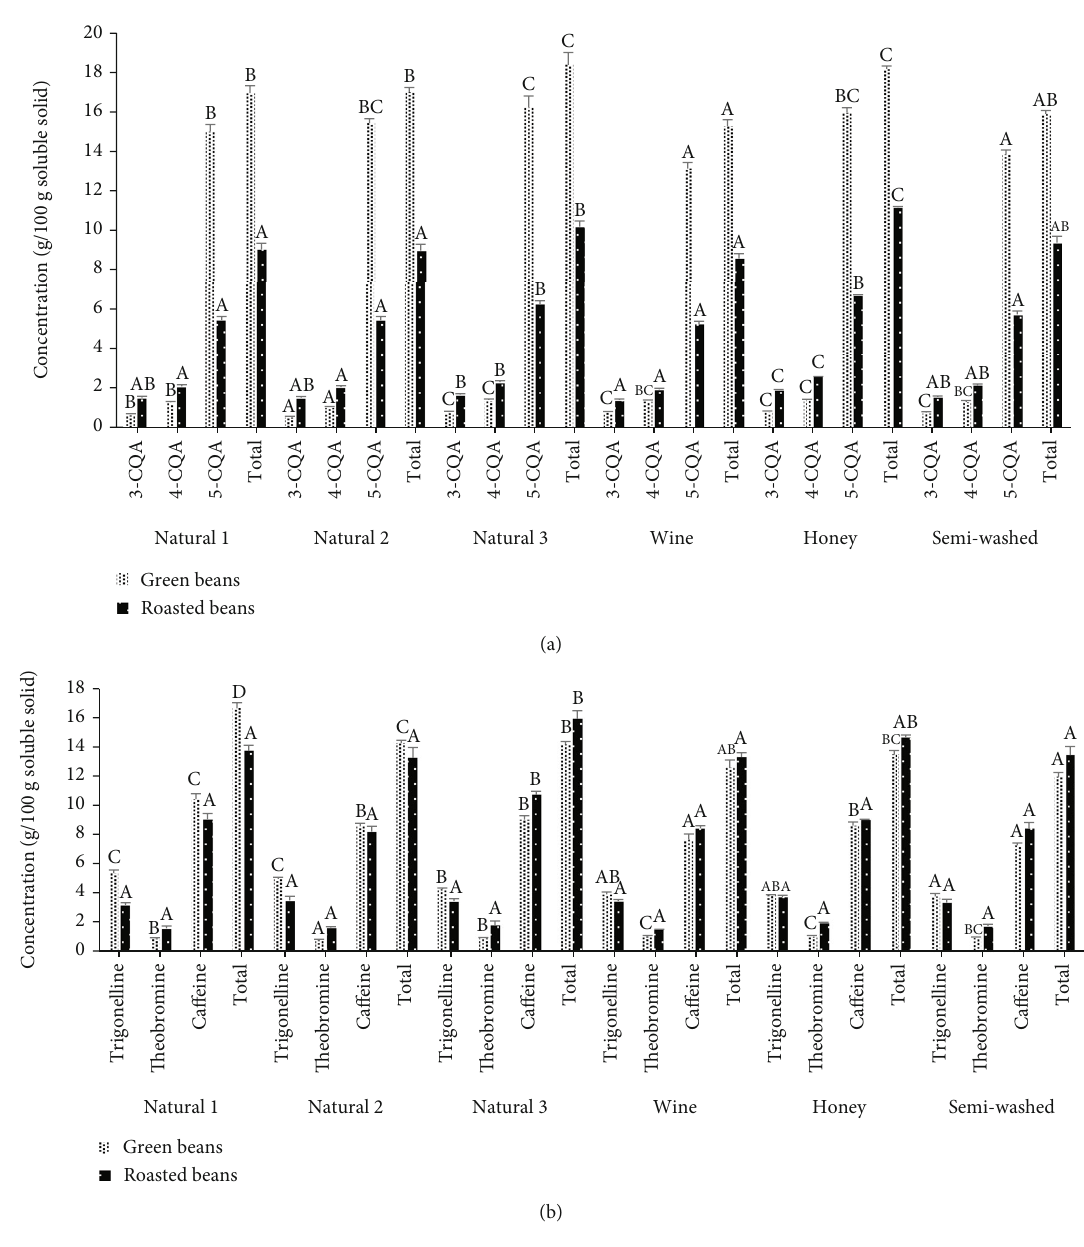
Figure 2: Ca ff eoylquinic acid (a) and alkaloid (b) composition of green and roasted bean extract of Excelsa co ff ee obtained from di ff erent processes. The value displayed in the fi gure is the average and standard error of three replications. ANOVA test on green and roasted co ff ee beans was carried out separately. Di ff erent superscripts indicate di ff erences among samples ( P < 0 : 05